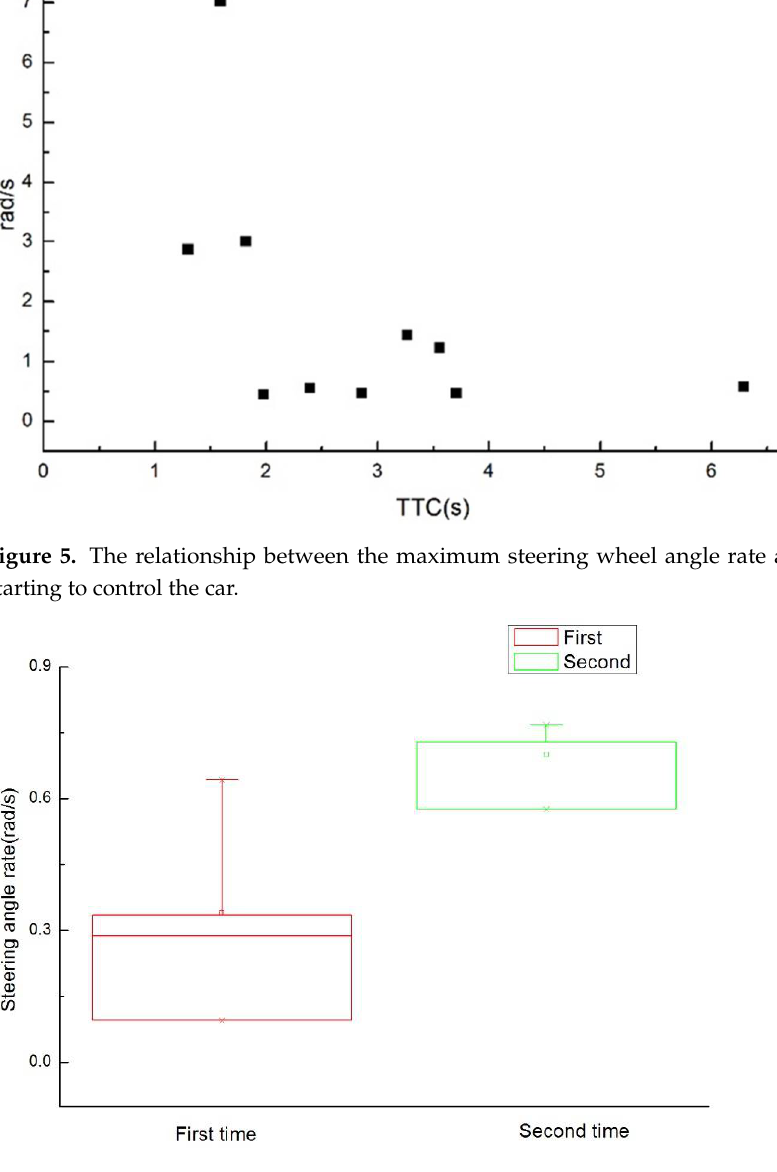
Figure 6. Comparison of steering wheel angle rates.